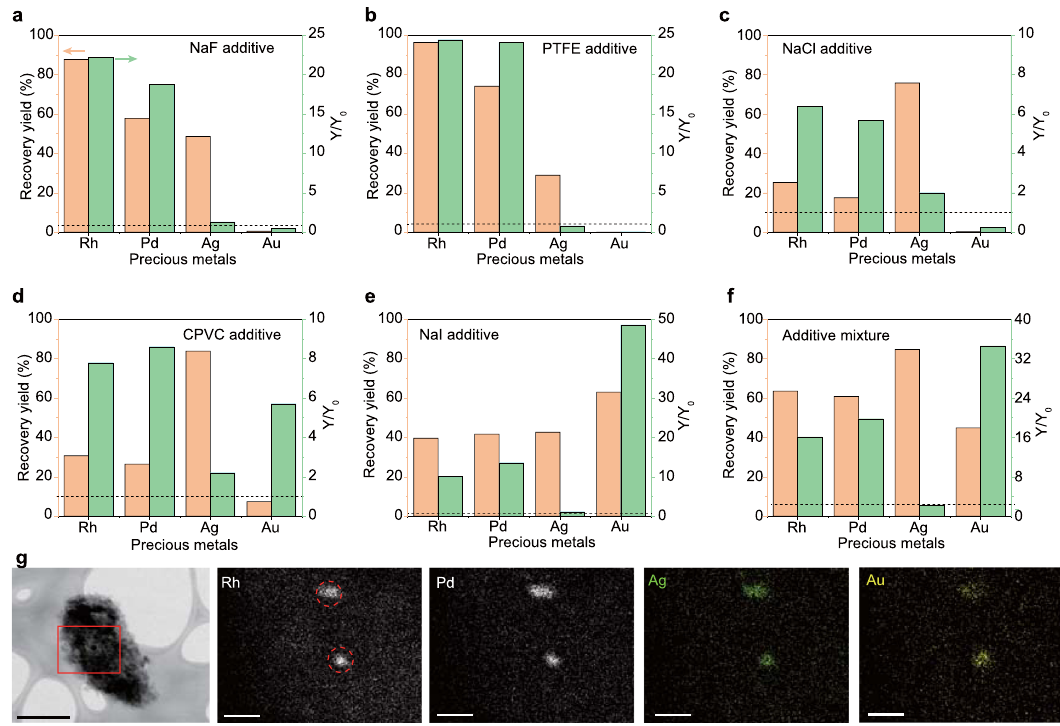
Fig. 2 Halide assisted improvement of recovery yield. Recovery yield of precious metals by using ( a ) NaF, ( b ) PTFE, ( c ) NaCl, ( d ) CPVC, ( e ) NaI, and ( f ) mixture of NaF, NaCl, and NaI, as additives. Y 0 and Y mean the recovery yield of precious metals without and with additives, respectively. The dashed line denotes Y / Y 0 = 1, meaning that there is no advantage of the additive if Y / Y 0 (cid:1) 1. The recovery yields were the average of three independent fl ash Joule heating (FJH) experiments ( n = 3). g Scanning transmission electron microscopy (STEM) image of the collected solids, and energy dispersive spectroscopy (EDS) maps of Rh, Pd, Ag, and Au at the rectangular region. Scale bar in STEM image, 0.5 μ m; scale bars in EDS maps, 100 nm. The dashed circles in Rh show the clustered